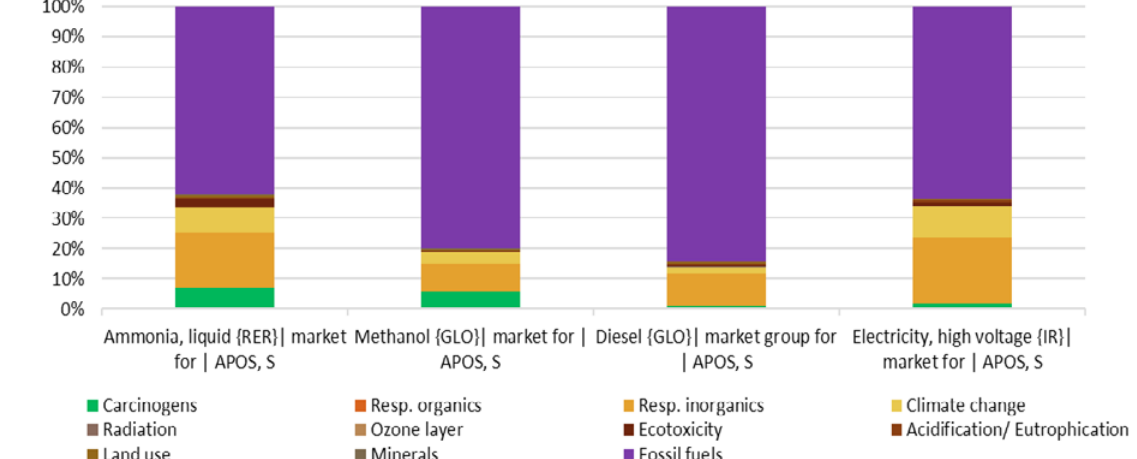
Figure 6. Final environmental points (single score) of life cycle using the eco-indicator 99 method